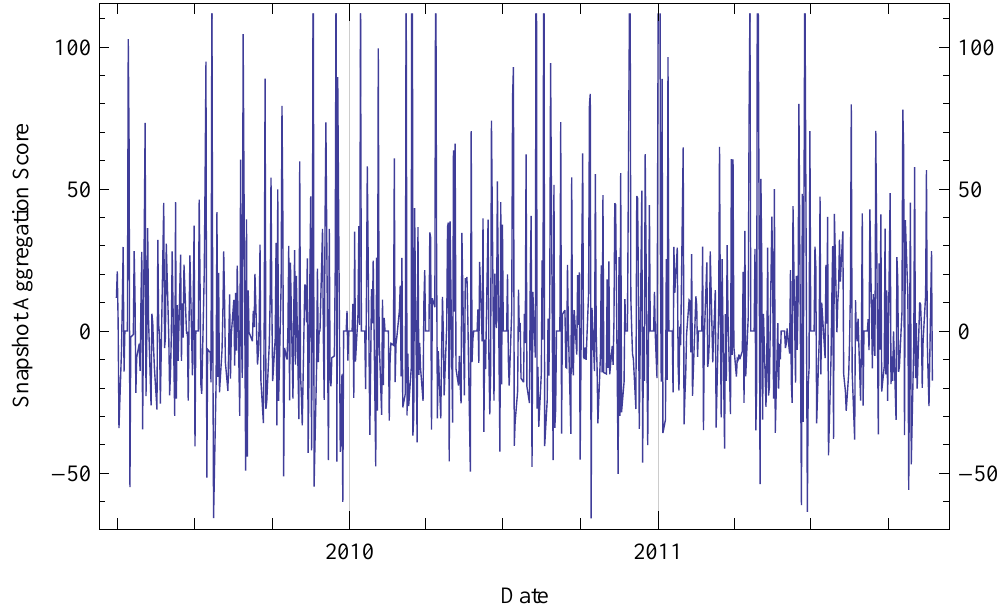
Figure 4. INTC score computed daily using snapshotting with the scoring function: